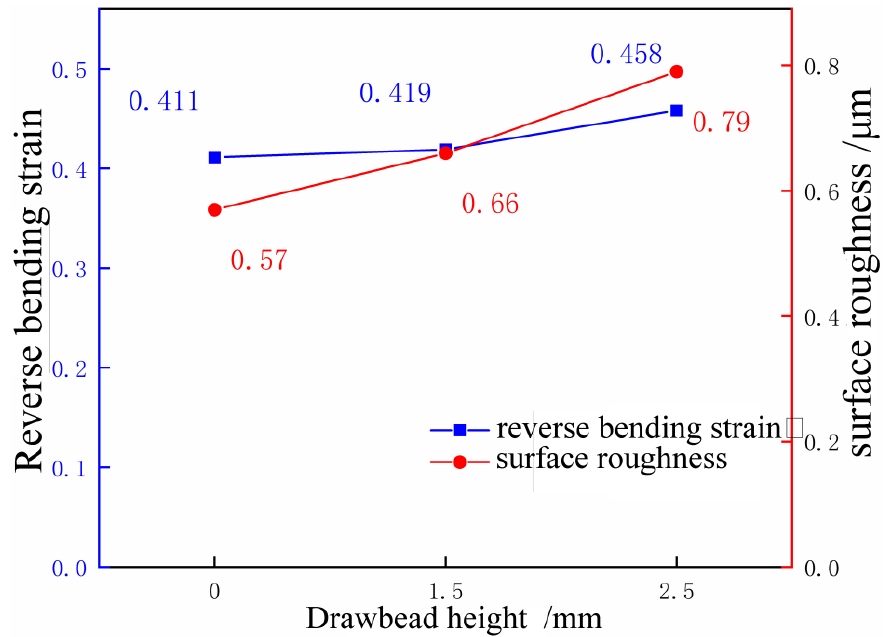
Figure 22. Reverse strain curves at different drawbead heights.